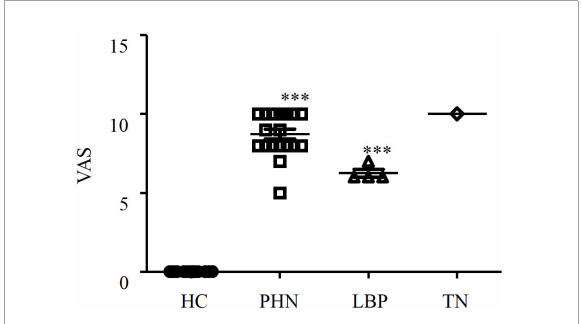
FIGURE1 Comparison of visual analog scale (VAS) in healthy controls and patients with postherpetic neuralgia (PHN), low back pain (LBP), or trigeminal neuralgia (TN). ∗∗∗ P <